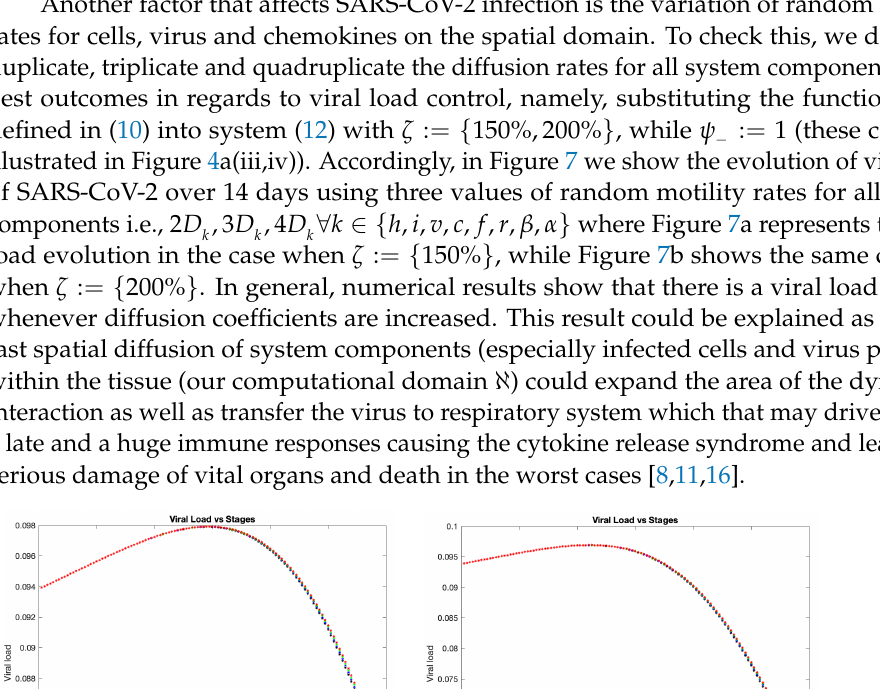
is represented by (10) and ψ : = 1 + − ; (ii) 2 D ; (iii) 3 D ; (iv) 4 D k k k k